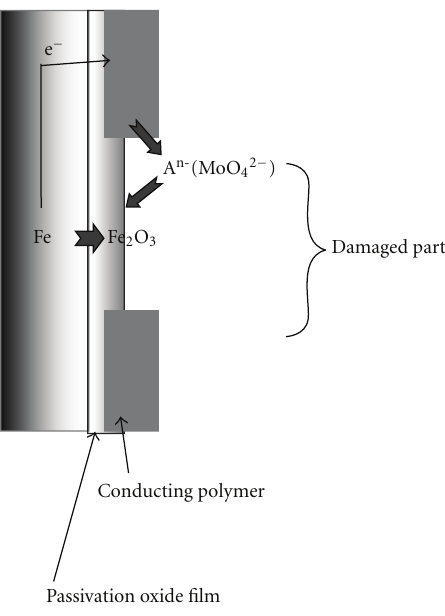
Figure 9: Schematic model of self-healing property of PPy- PMo 12 /PPy-DoS bilayered PPy. Molybdate anions, dissolving from PPy film, reform a passive oxide at the damaged